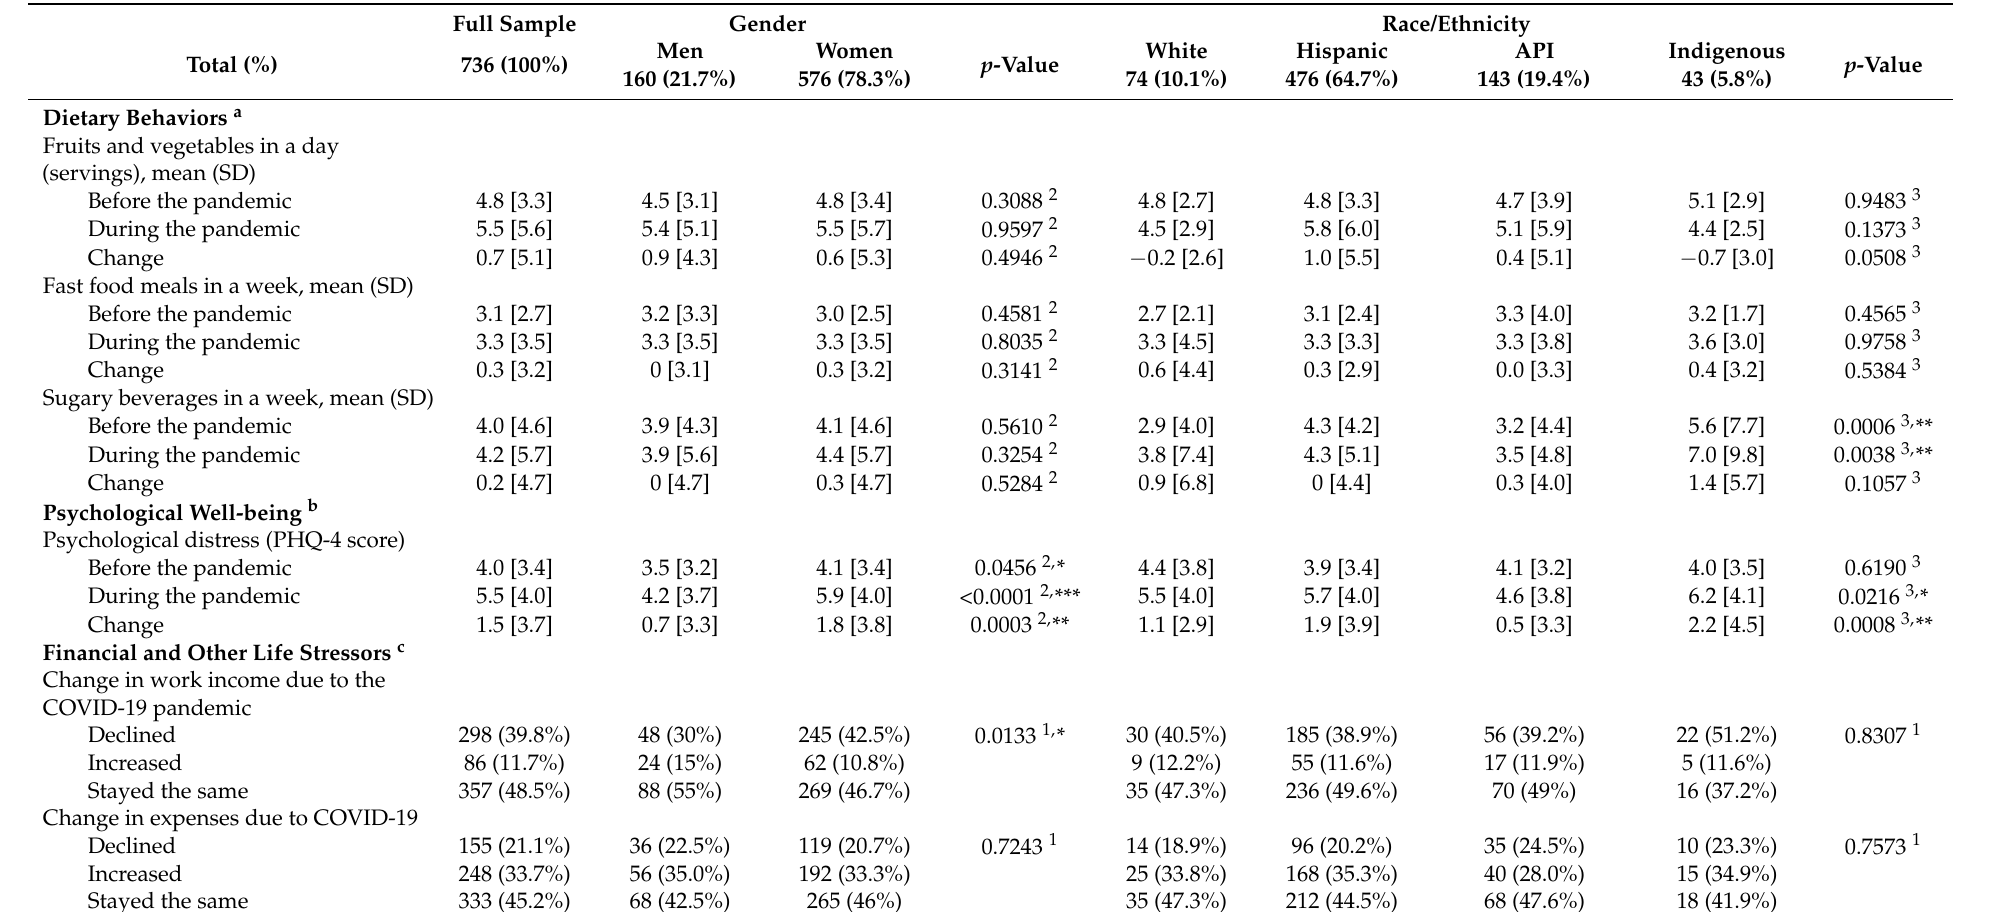
Table 2. Survey participant characteristics from the Health During the COVID-19 Pandemic Student Survey by gender and race/ethnicity, California State University, Los Angeles,